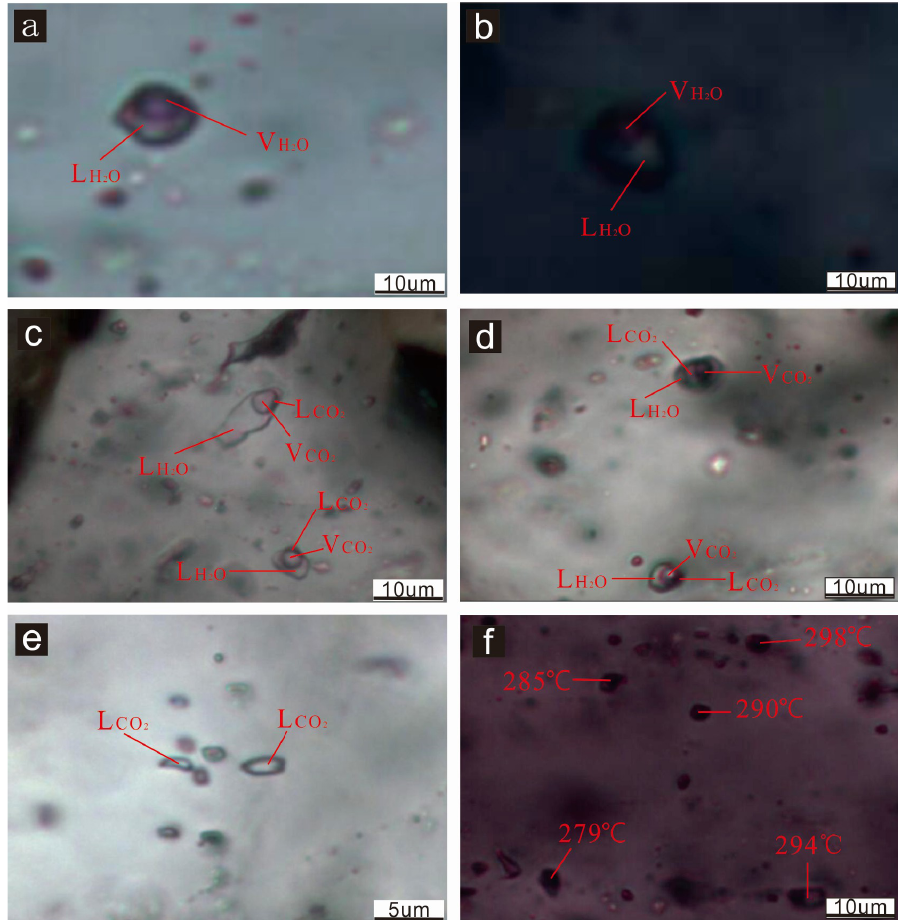
Figure 9. Photomicrographs of the fluid inclusions in the Sizhuang gold deposits: ( a , b ) Type 2 aqueous inclusions contain two phases (liquid H 2 O and vapor H 2 O); ( c , d ) Type 1 H 2 O–CO 2 inclusions generally consist of three phases (liquid H 2 O, liquid CO 2 and CO 2 rich vapor); ( e ) Type 3 CO 2 inclusions are small and infrequent in this study; and ( f ) the inclusions with a total homogenization temperature of 298 ◦ C is a type 2 aqueous inclusion. The other inclusions are Type 1 H 2 O–CO 2